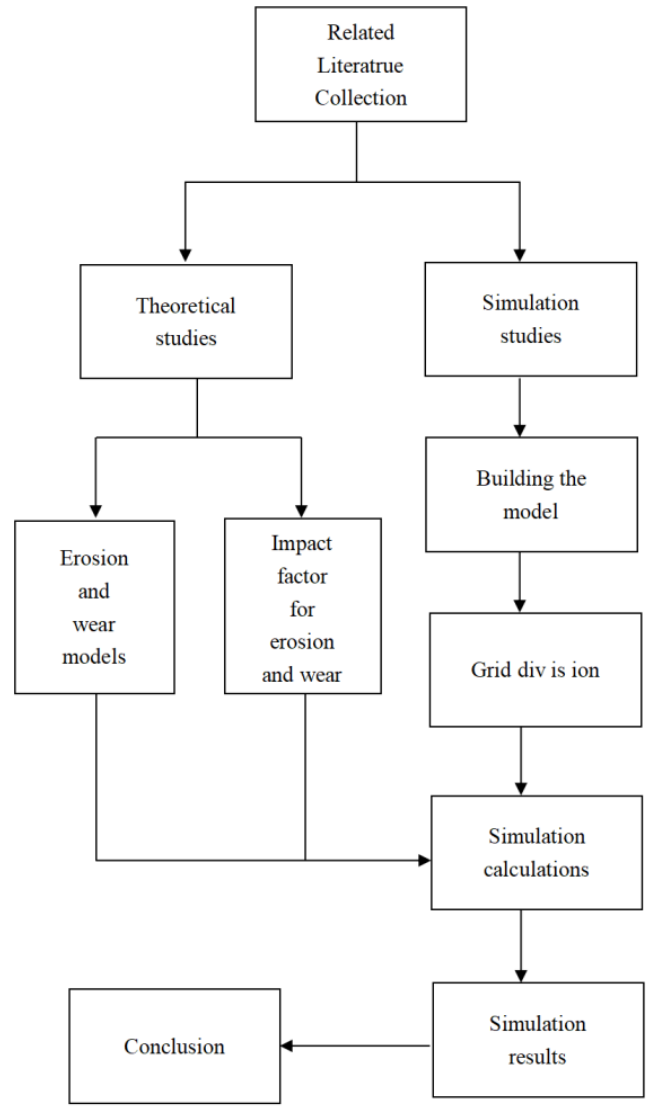
Figure 1. Overall work flow chart.